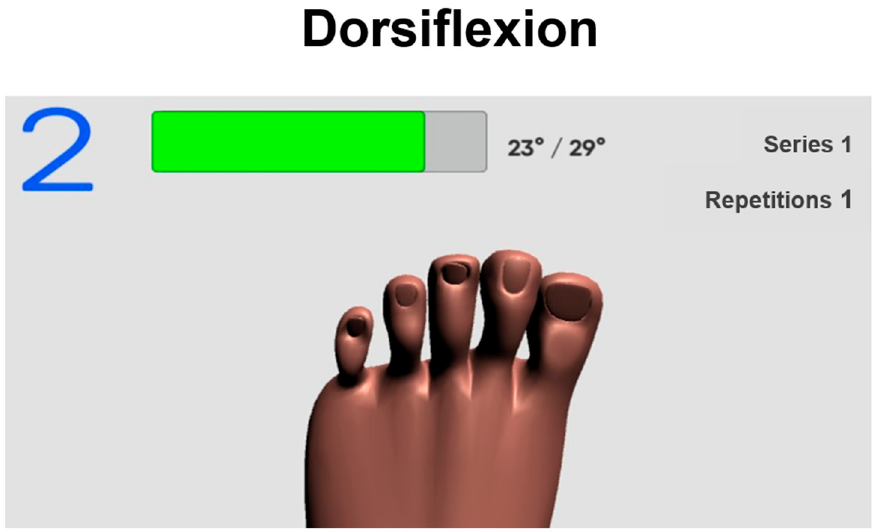
Figure 5. Graphical user interface.